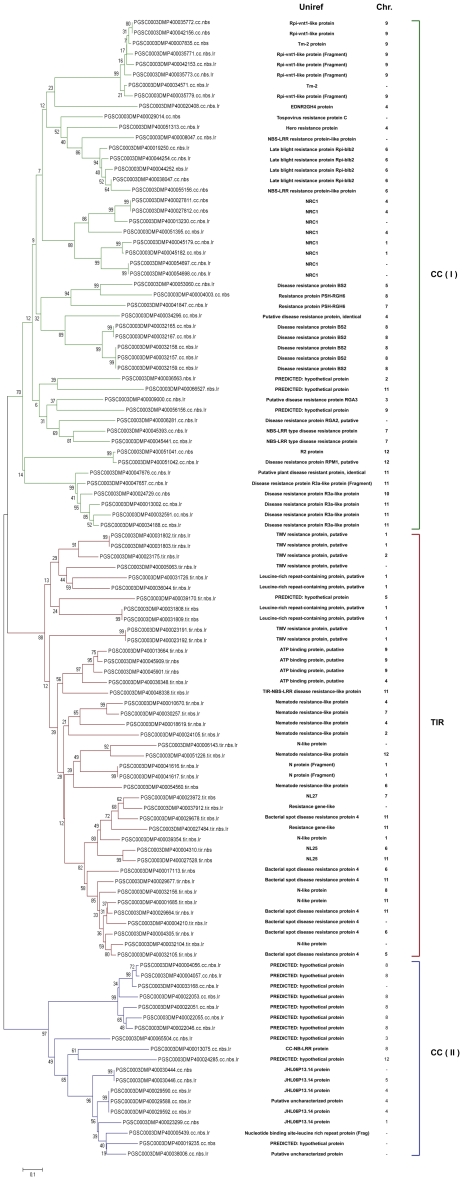
Phylogenetic construction of the NBS-LRR proteins in Solanum tuberosum group phureja.The neighbor-joining tree was constructed using the sequences of 110 NBS-containing proteins using MEGA4 software [31]. Sequences were trimmed to extract just the NBS domain. Bootstrap values are indicated on the branches. Each protein is encoded by its full PGSC code followed by its type (CNL, TNL, TN and so on); green, blue and red branches correspond to CC(I), CC(II) and TIR clades respectively. Functional annotation and chromosome location for each protein are positioned in the right margin.